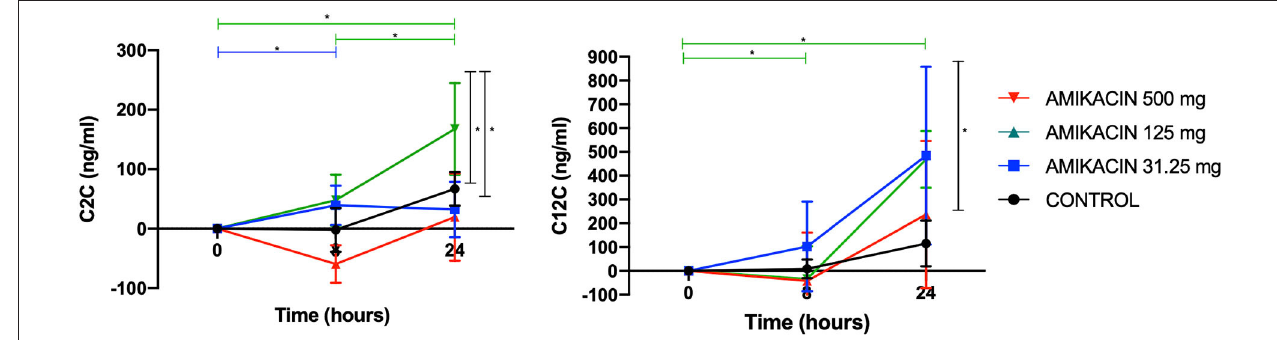
FIGURE 3 | Concentrations of the biomarkers of collagen degradation following a single intra-articular administration of amikacin at three doses compared to the control, normalized to baseline. Competitive enzyme-linked immunosorbent assays (ELISAs), previously validated for use in equine synovial fluid, were used to measure the biomarker concentrations of neo-epitope C2C (biomarker of type II collagen degradation) and C12C [biomarker of type I (soft tissue) and type II (cartilage) collagen degradation]. Results are expressed as the mean ± SD, normalized to baseline.